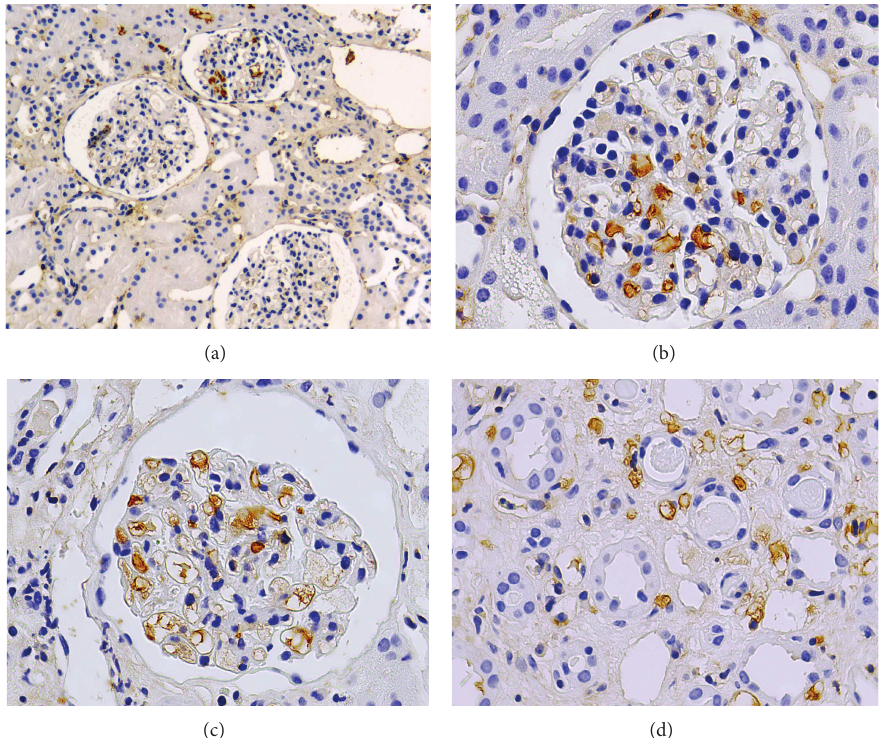
Figure 3: Expression of prostacyclin synthase in various renal diseases. (a) IgA-nephropathy, (b) focal segmental glomerulosclerosis. Glomerular (c) and medullary (d) expression of PGIS in endothelial cells and peritubular capillaries in a transplanted kidney with chronic rejection.